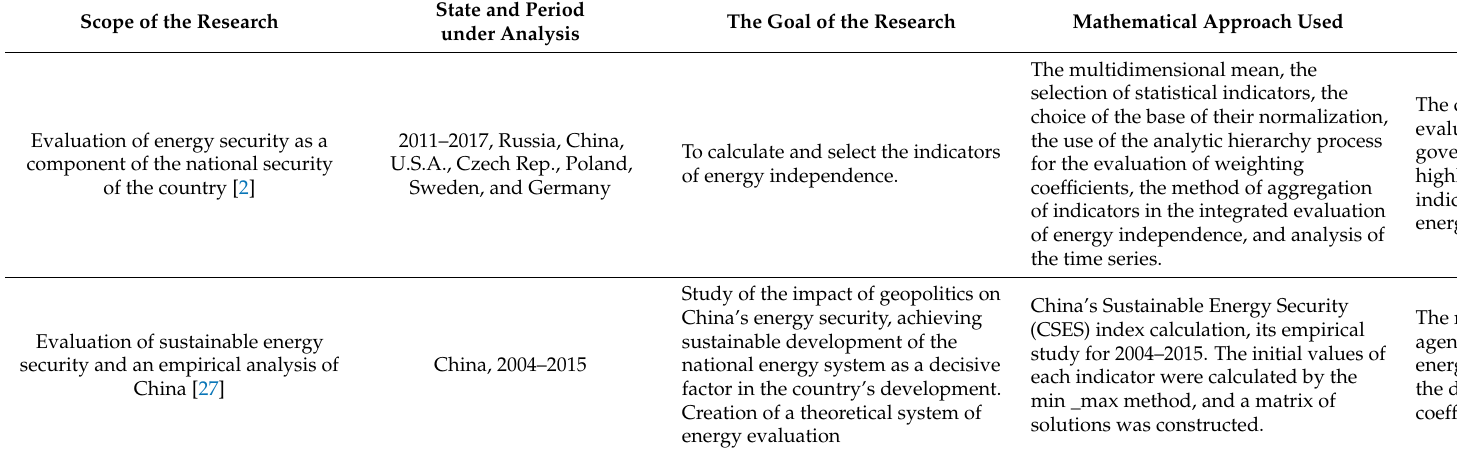
Table A2. National security vs/along with energy security: correlations and causality